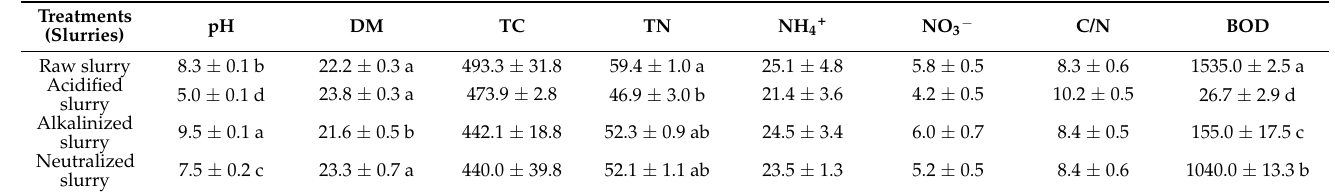
Table 2. Physicochemical characteristics of each slurry treatment at the beginning of the experiment (mean ± standard deviation) ( n = 3).